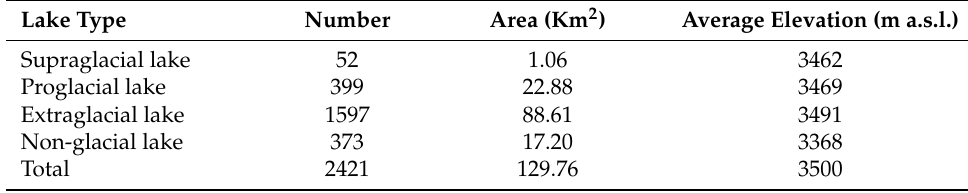
Table 2. Lake statistics of different types of lakes in the TS during 2015.